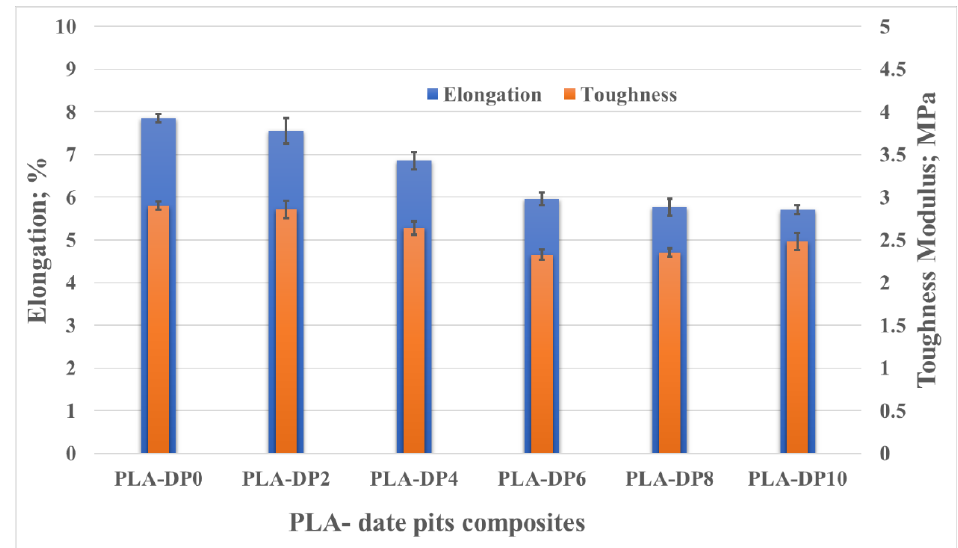
Figure 14. Elongation and toughness modulus of PLA – date pit composites.